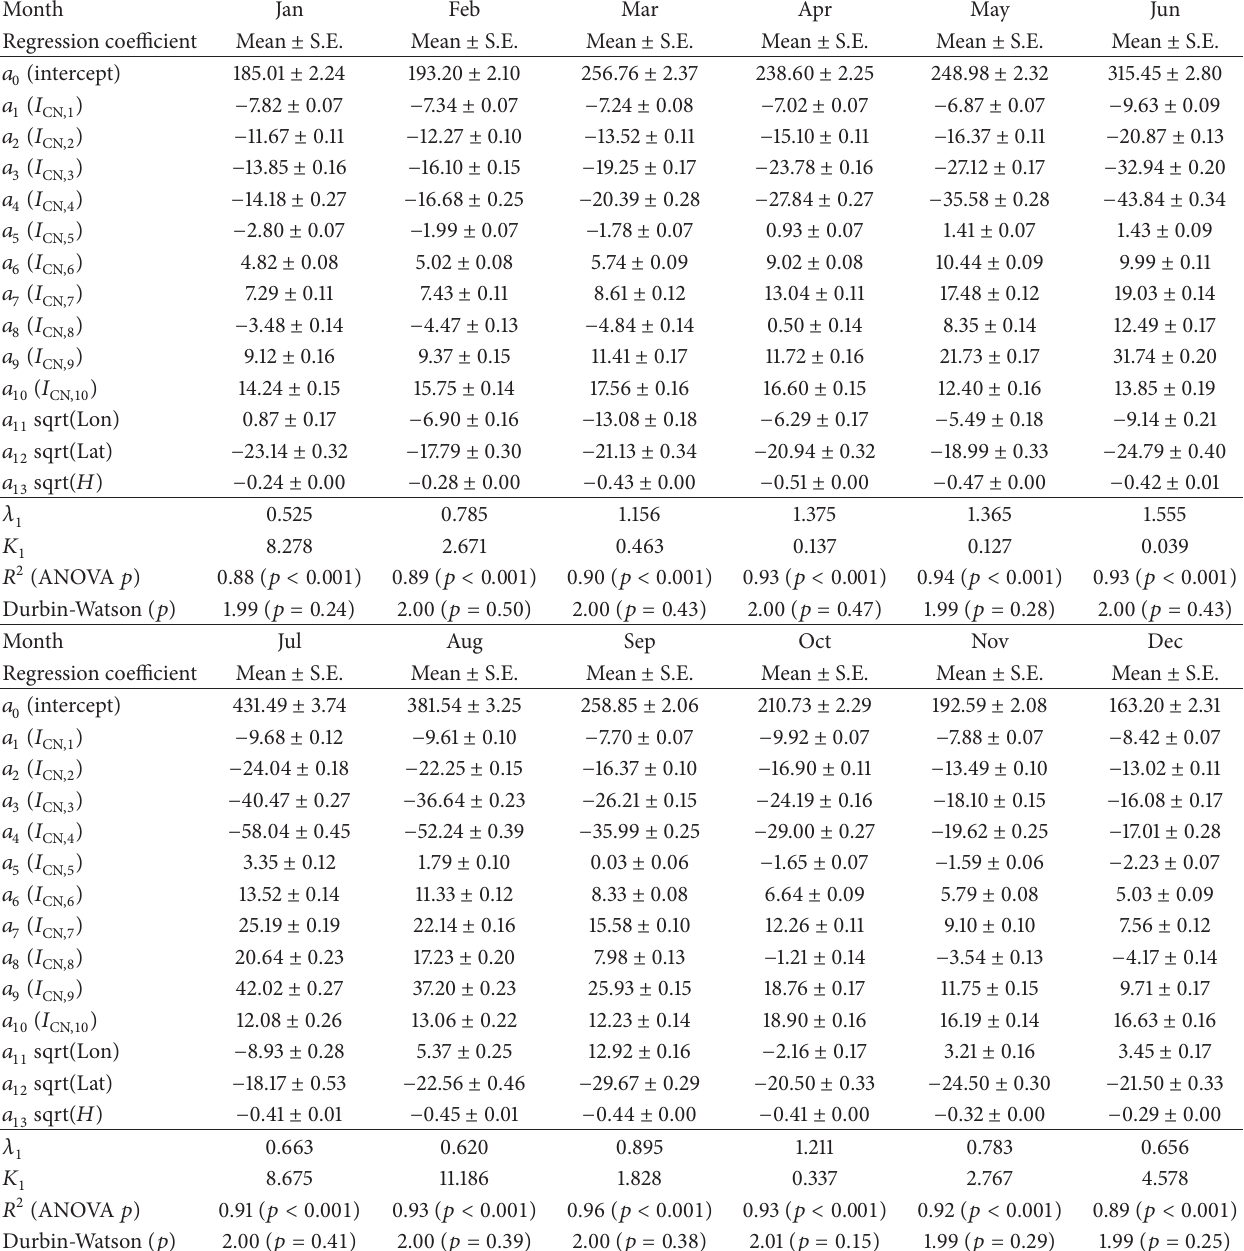
Table 5: Regression coefficients and statistical tests of the general linear model described by (2) for each